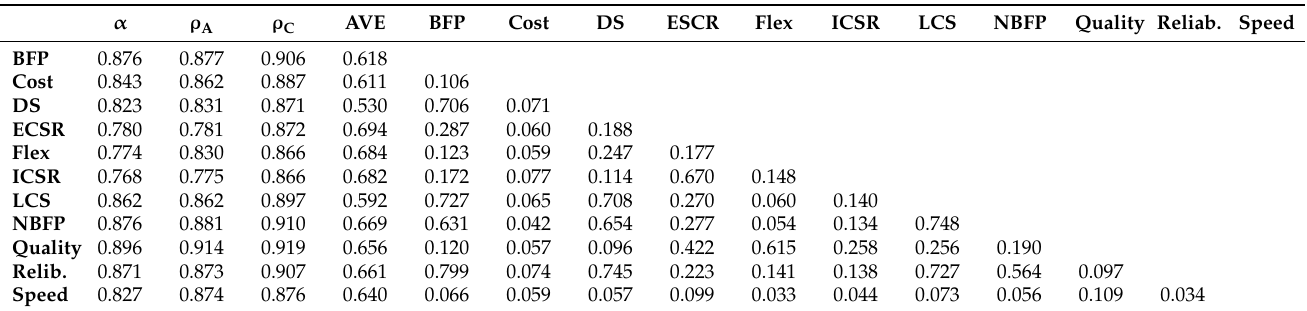
Table 2. Reliability and